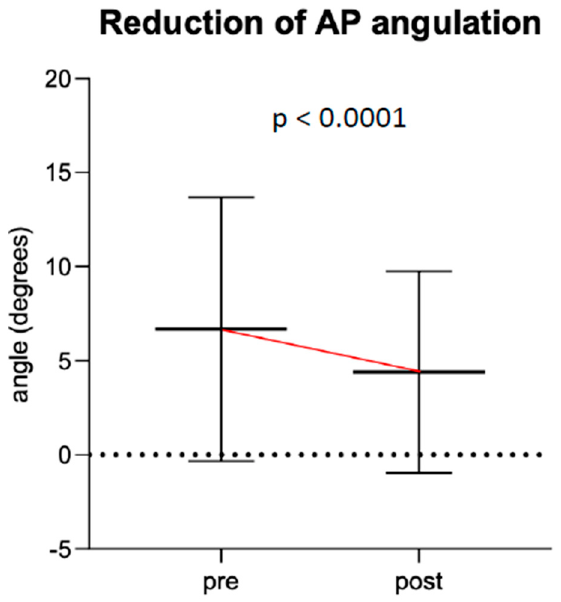
Figure 7. Change in median coronal angulation before and after cast wedging.